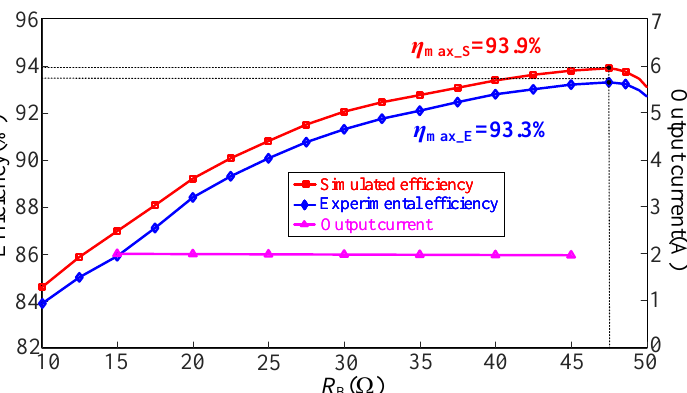
Figure 13. Profiles of power transfer efficiency and output current of the CLC/N compensated WPT system against varying load resistance.